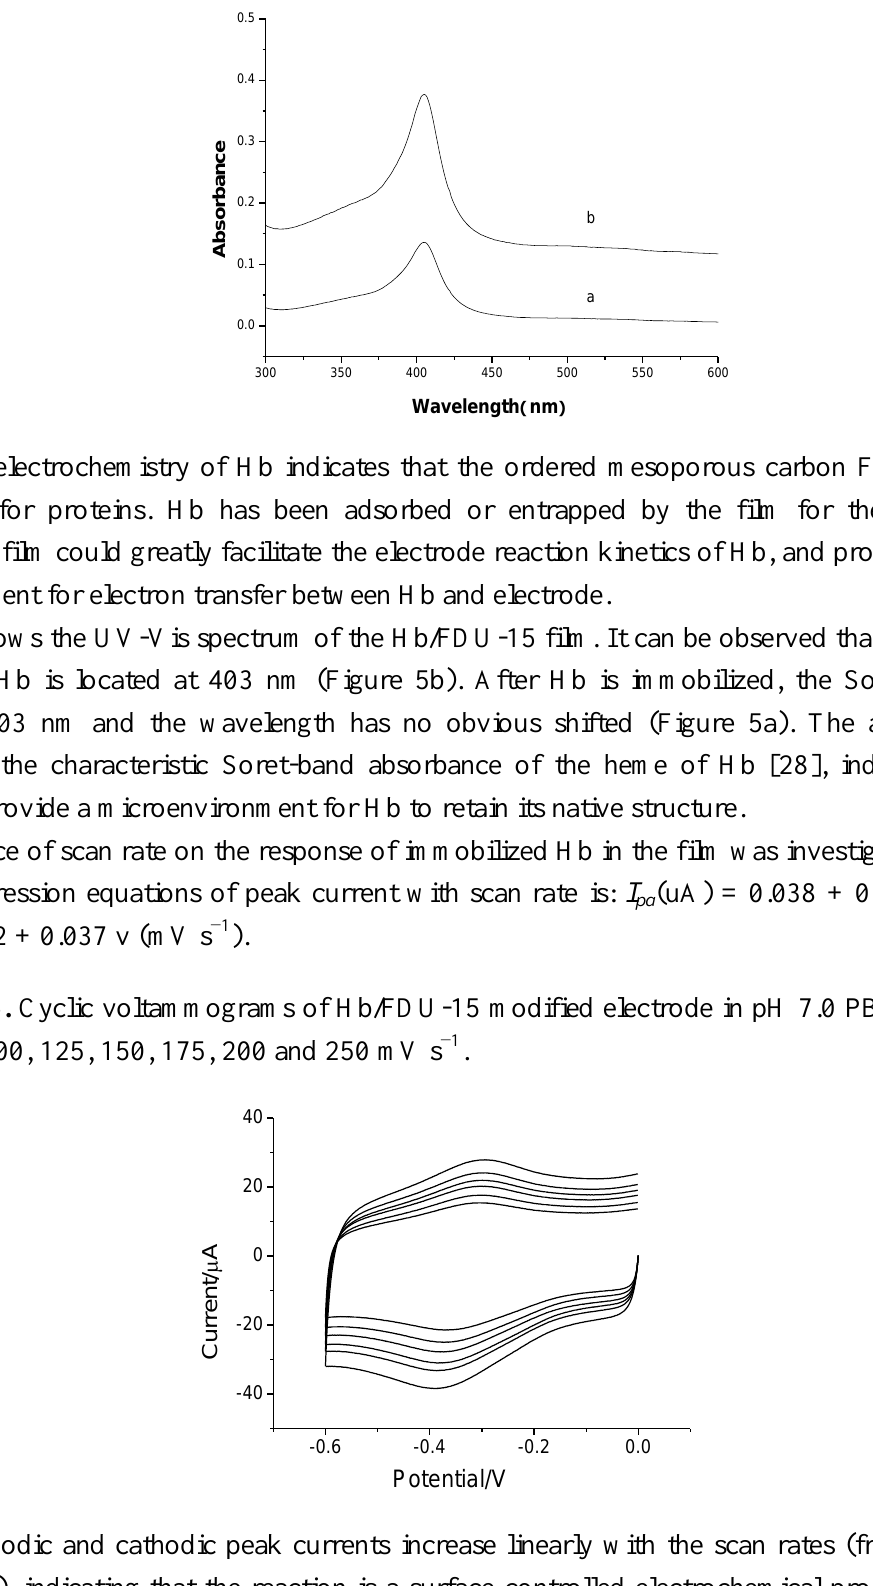
Figure 5. UV-Vis spectroscopy of (a)Hb/FDU-15 film and (b)Hb in pH 7.0 PBS.